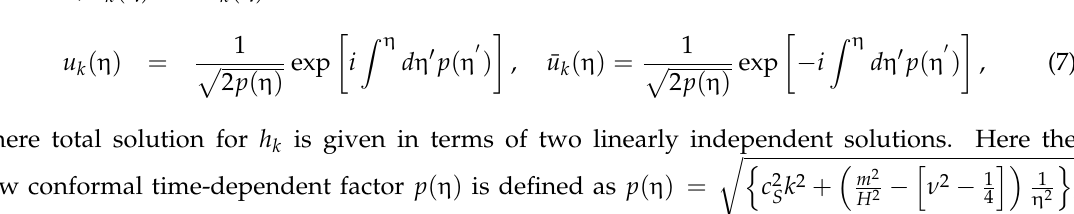
= 1. Here pictures are taken from H 2